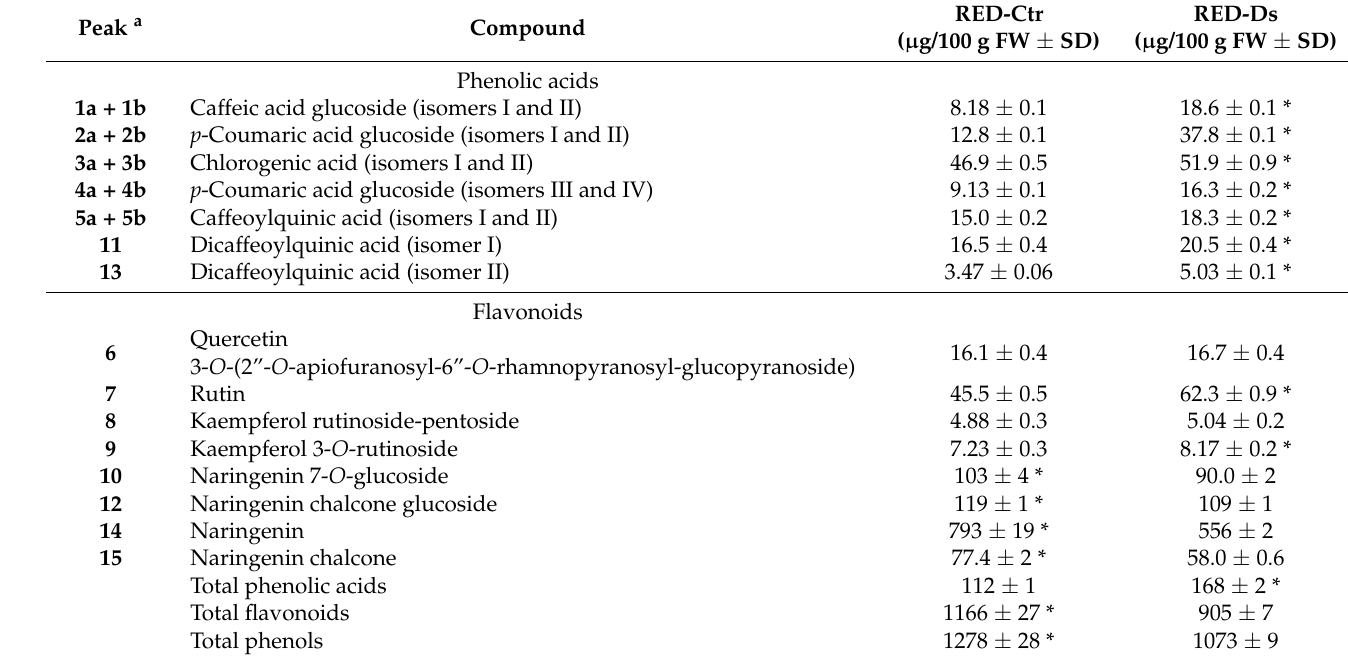
Figure 4. Skeletal muscle cell marker gene expression by RT-PCR. Plots show gene expression of late muscle cell markers Myosin heavy chain-2 (MYH2), Troponin T (TNNT1) and Myogenin (MYOG), normalized to three most stable reference genes, eEF1a, RPL13a and B2M, (Avg M value = 0.269) and then the 2 −ΔΔCt algorithm was applied for relative quantification. *** p < 0.001 vs. day 1 using Student’s t -test. 2.3. In Vitro Sarcopenia Induction DEXA was used to induce myotubes atrophy [24], simulating sarcopenia. In particu- lar, myotubes derived from HSMM were treated with DEXA (50 µM) for 48 h and then fixed and immuno-stained for MYH2. Nuclei were visualized by Hoechst staining. Total myotube areas were measured as described by Lecomte et al. [26] and results were plotted as the percent decrease in myotube area compared to untreated control cultures. Repre- sentative images of untreated myotubes or those treated with DEXA are shown in Figure 5a. HSMM myotubes undergo an atrophy-like response to DEXA treatment (Figure 5b, p < 0.05 vs. untreated cell).